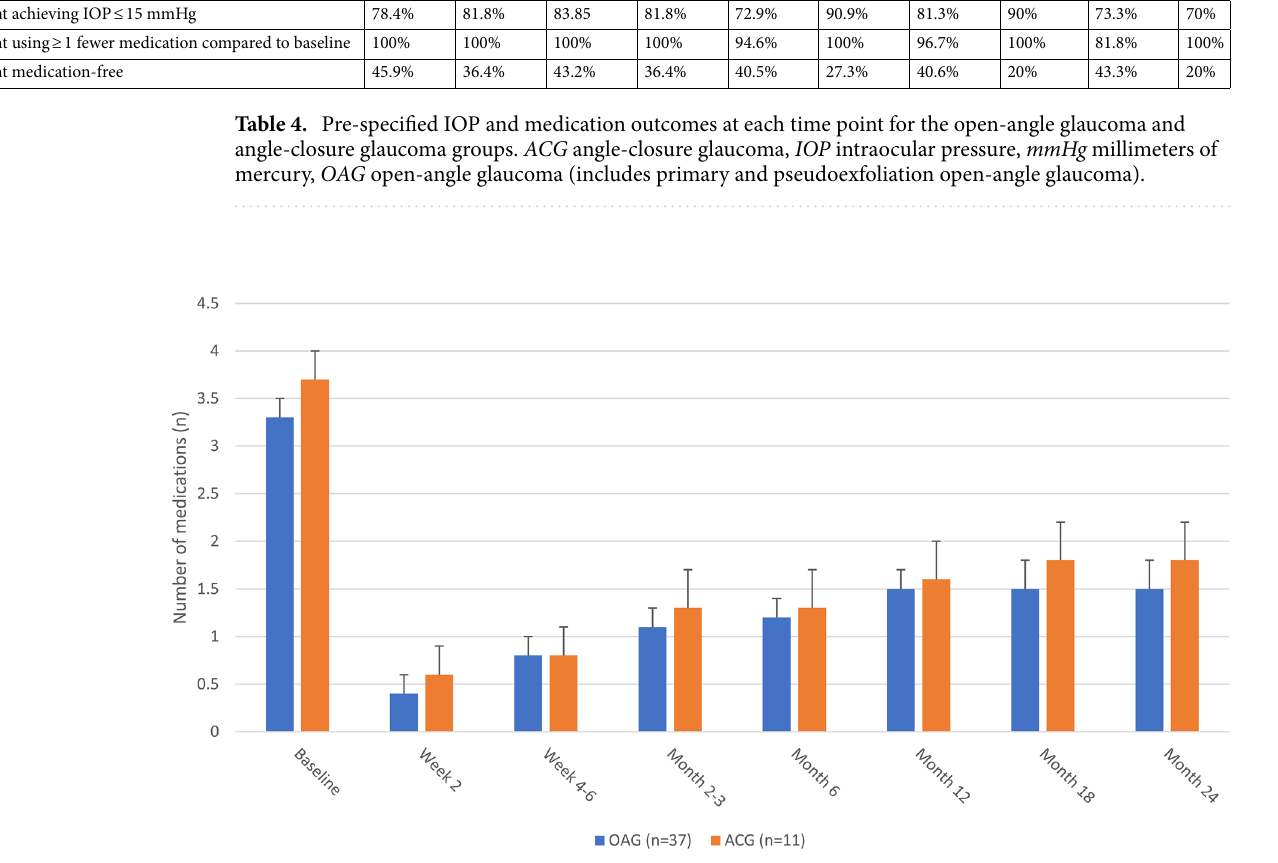
Figure 2. Mean number of IOP-lowering medications at each visit by glaucoma subtype. Error bars represent standard error. p < 0.0001 at all-time points in the full data set of all eyes (n =